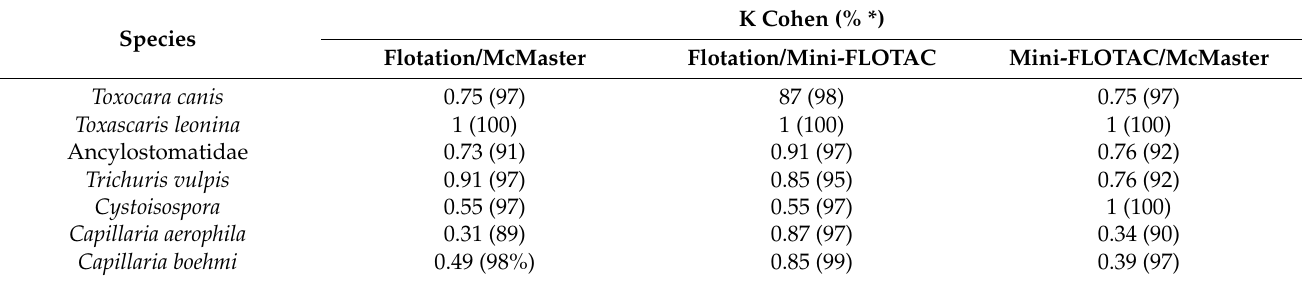
Table 11. Cohen’s kappa coefficient was calculated to assess the agreement between techniques employed in the present study for canine fecal samples.